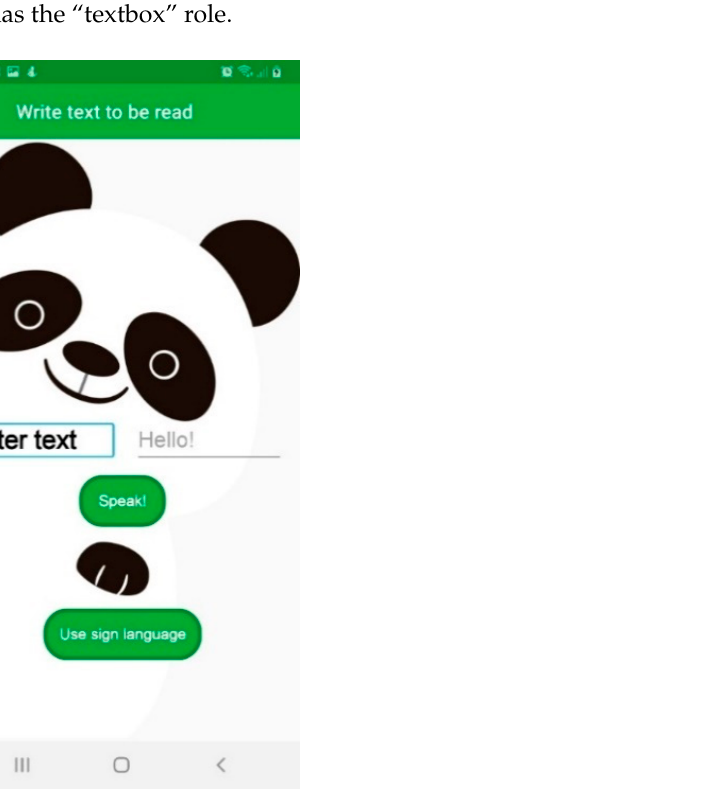
Figure 10. PandaSays Text-To-Speech screen with TalkBack on.